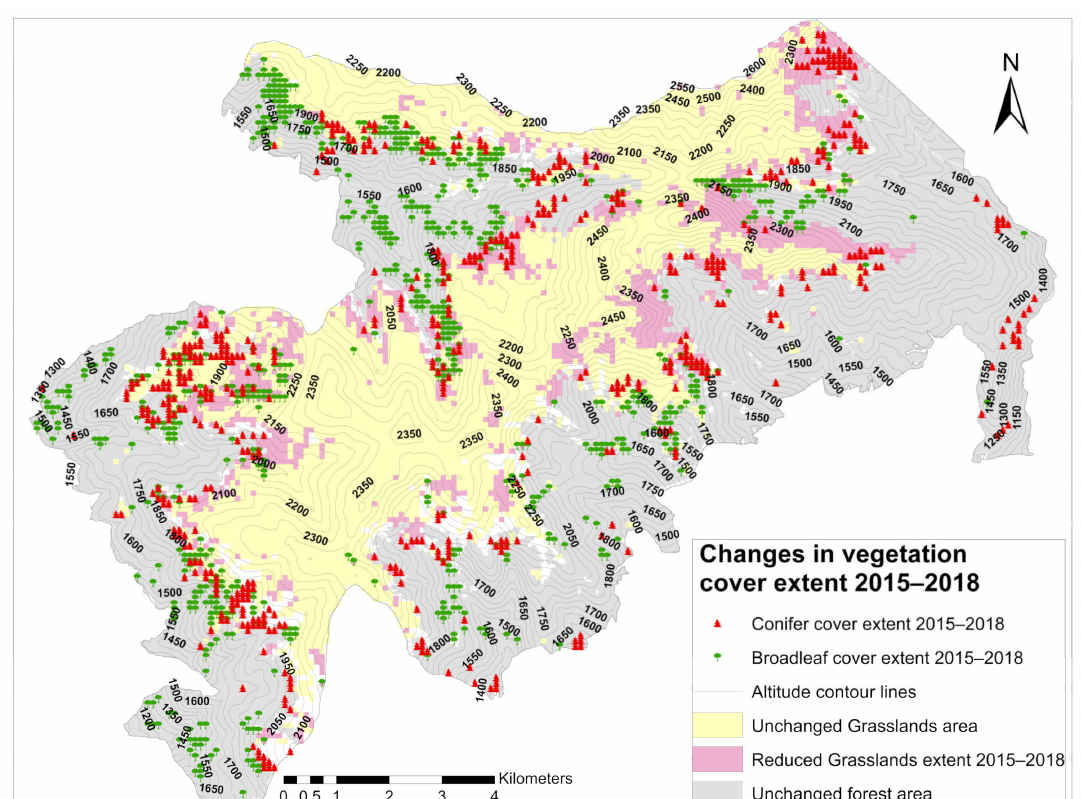
Figure 11. Changes in spatial distribution of grassland and forest ecosystems at pixel size of 100 m between base years 2015 and 2018. The extent of areas with higher tree cover density in 2018 is marked with coniferous and deciduous symbols at the centroids of the respective pixels. The changes are confirmed by NDGI in satellite scenes as early as